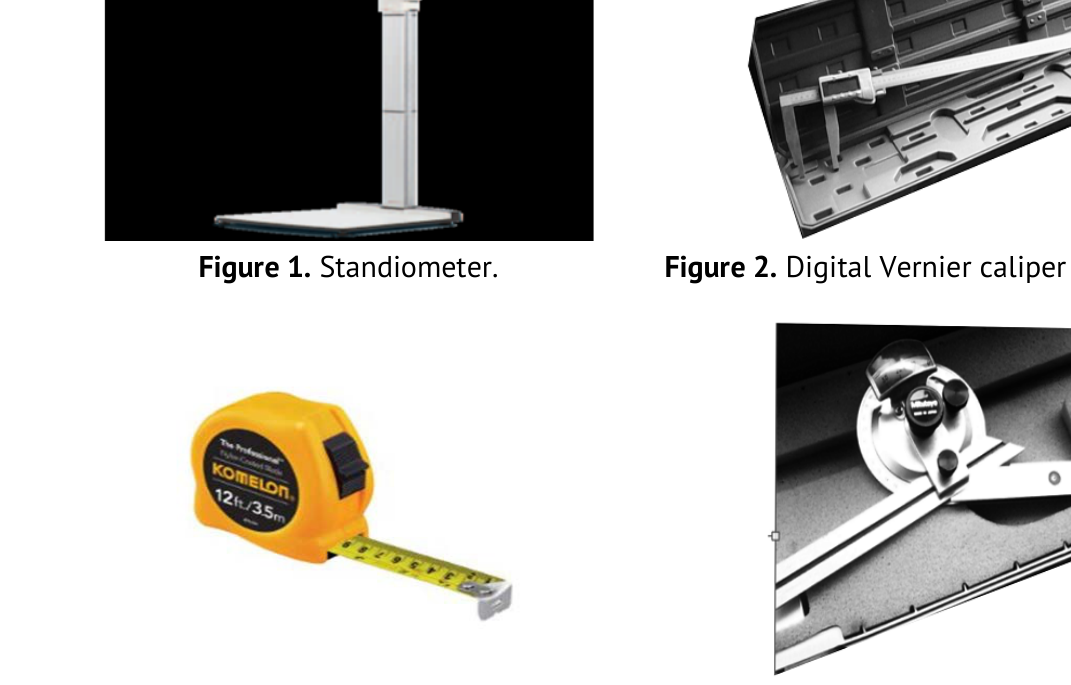
Figure 3. Steel Tape. Figure 4. Universal bevel